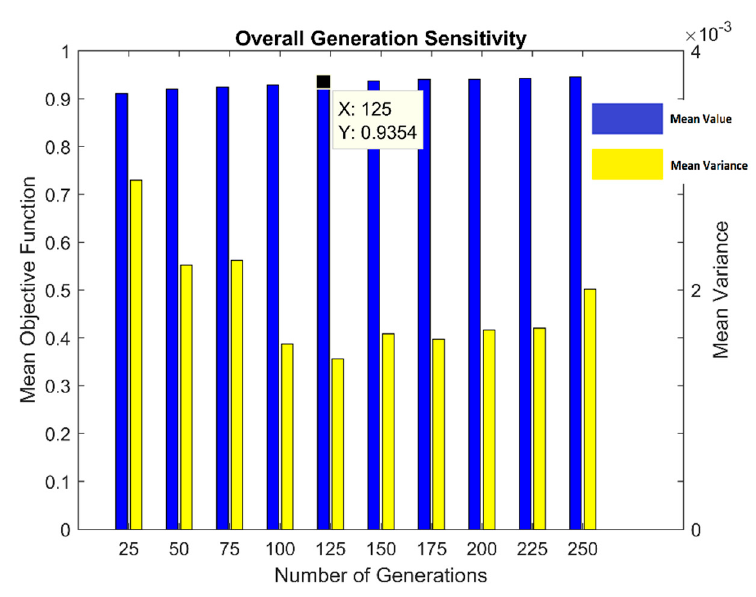
Figure 8. Sensitivity analysis of GA evaluating the number of generations.